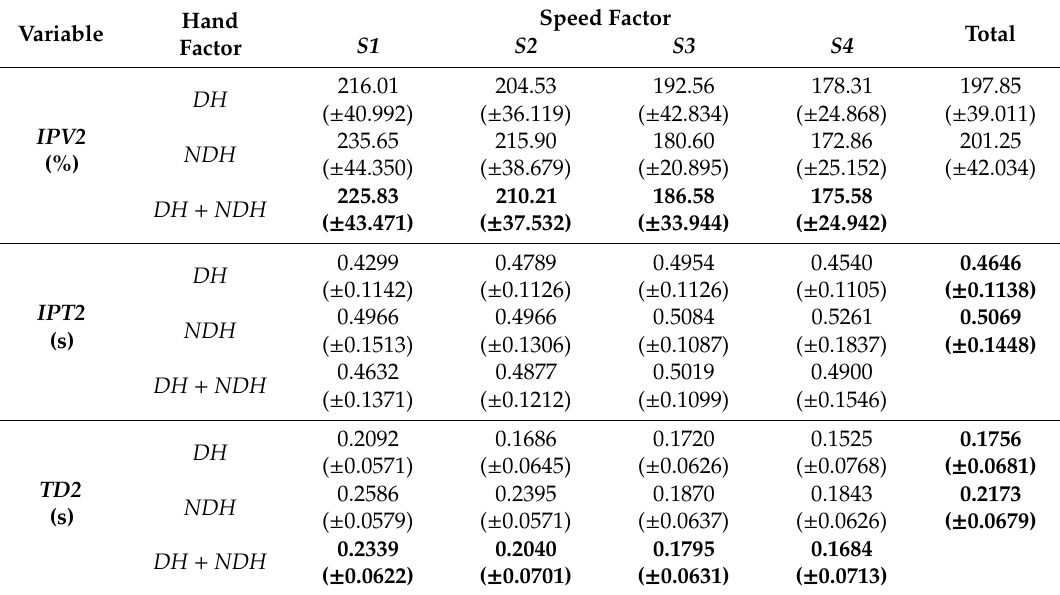
Figure 3. Evaluation of transient responses of the circular tracking movement based on initial peak velocity ( IPV2) on the frontal plane. ( A ) The values of IPV2 of 29 subjects for four speed factor levels. ( B ) The pairwise comparison between the dominant hand ( DH ) and NDH was shown for IPV2 of all the speed factors. ( C ) Pairwise comparisons of IPV2 were represented for the speed factor within DH and ( D ) within NDH . ( E ) The results of pairwise comparison of IPV2 in both DH and NDH . Table 2. Statistical results of each